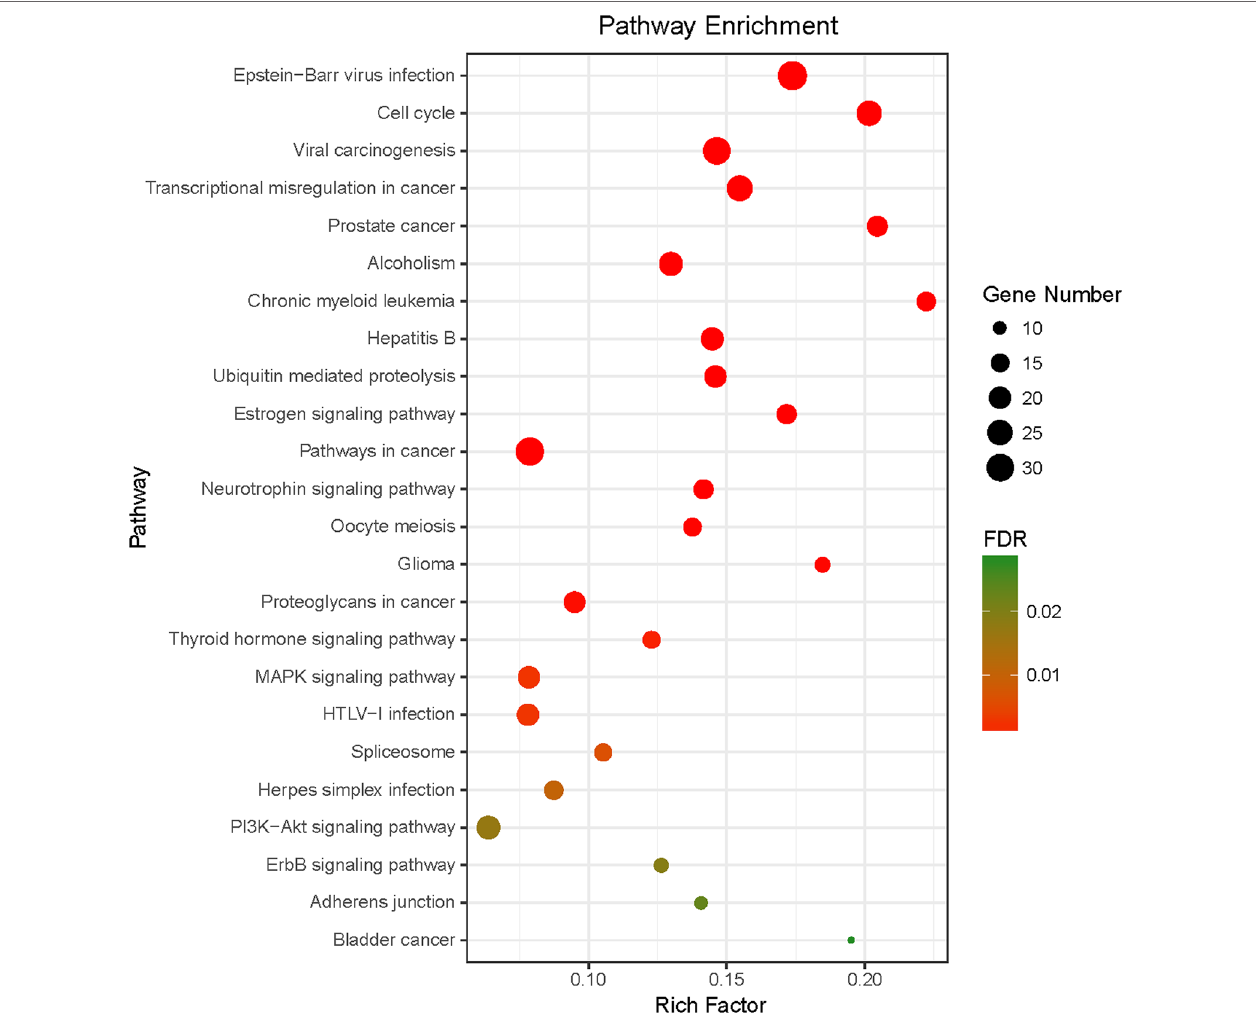
FIgUrE 5 | KEGG pathway enrichment of candidate targets of YQSX against ITP. Pathways that had significant changes of FDR <0.05 were identified. Size of the spot represents number of genes and color represents FDR value.